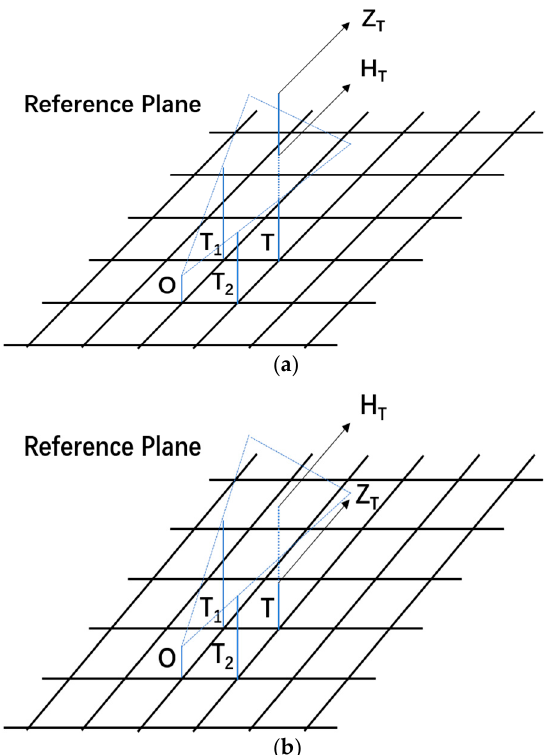
Figure 6. Visual judgment based on reference plane. ( a ) Points O and T are inter-visible; ( b ) points O and T are not inter-visible.